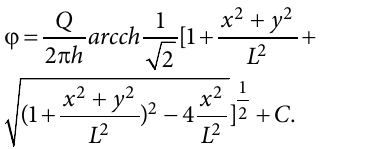
(2) Potential distribution function of multiple fractures in casing completion well The heel is considered the origin of horizontal well, and the parallel direction of the fracture is the X-axis. While the horizontal wellbore is the Y-axis, and the rec- tangular coordinate system is established, as shown in Figure 7. From the origin, the fractures are denoted as F , 1 F , ..., F , respectively. The lengths of the half fractures are 2 n L , L , ..., L respectively. The widths of the fractures are 1 2 n similarly defined as w , w , ..., w , respectively; the values 1 2 n of permeability are respectively denoted as K , K , ..., K , 1 2 n respectively; the productivities are Q , Q , ..., Q , respec- 1 2 n tively; the middle points of the fractures (ie, the junction of the fracture and the wellbore) are denoted as y , y , ..., 1 2 y , respectively. n